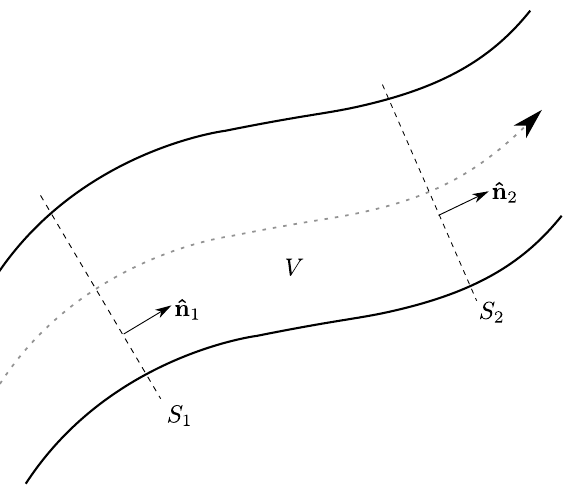
Figure 2. Sketch of the mixed convection duct flow discussed in Section 4.